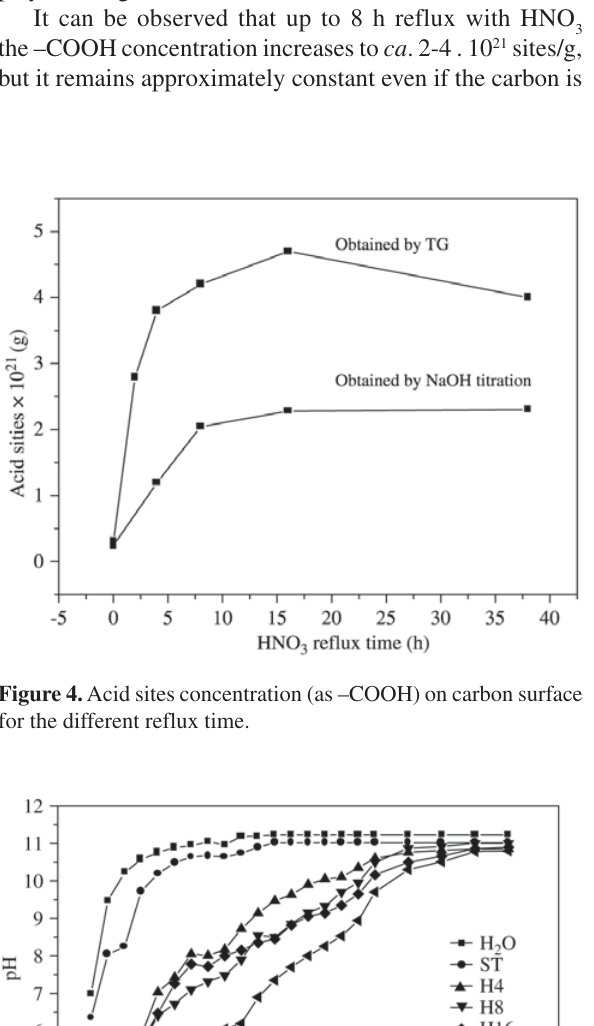
treated carbons. 3